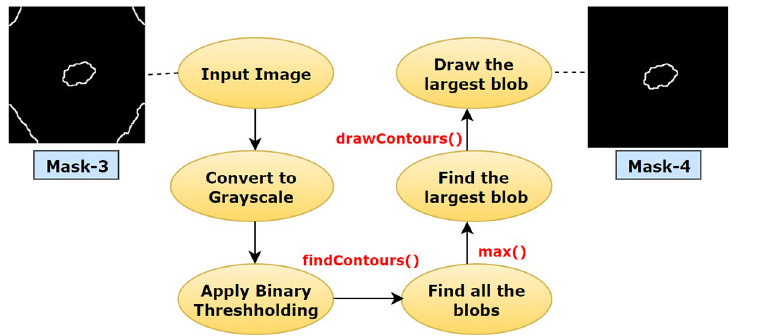
Fig 14. Process flow of extracting the largest blob from